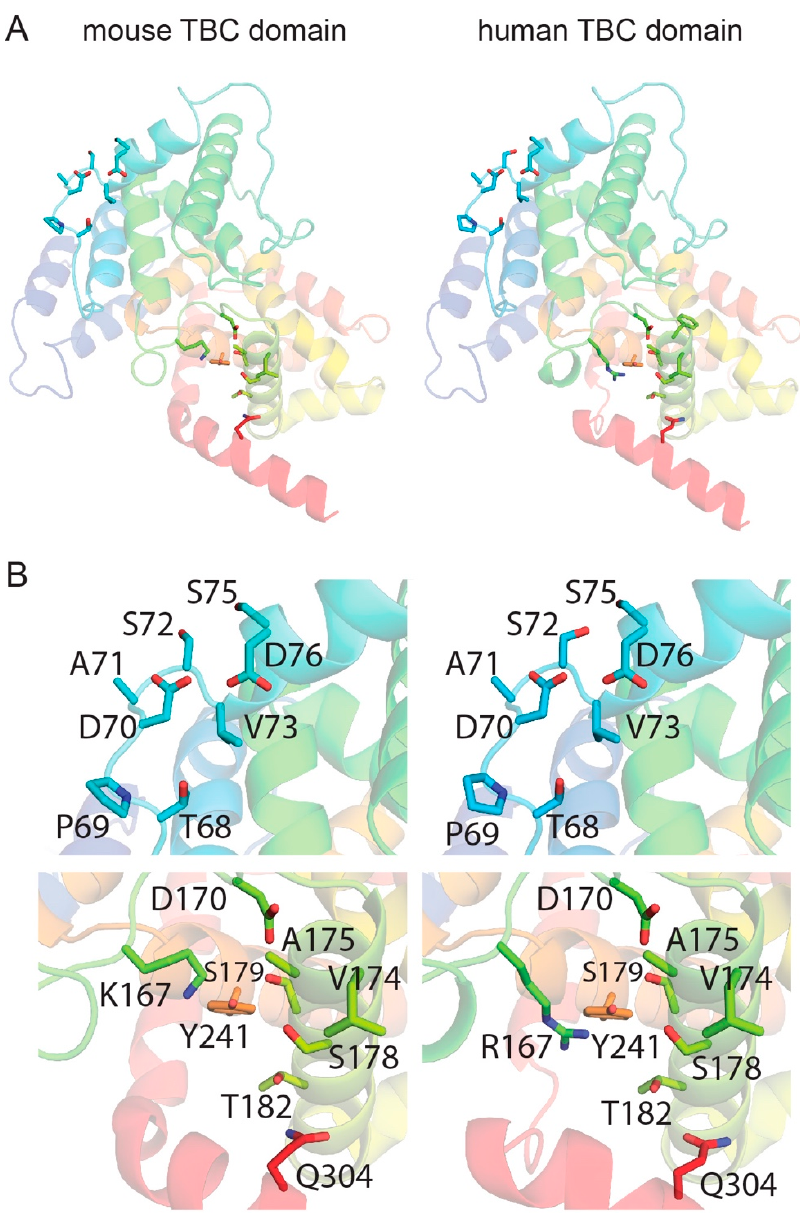
Figure 5. Computational modeling of human TBC1D24 and mouse TBC1D24. ( A ) Models of the TBC domains of mouse (left) and human (right) of TBC1D24 shown as a cartoon. Residues Asp70 and Ser178 as well as those within 6 Å are shown as sticks. ( B ) Enlarged view of the Asp70 (top) and Ser178 (bottom) sites in mouse (left) and human (right) models. Residues within 6 Å of Asp70 or Ser178 are also shown as sticks and indicated with labels. A, Alanine; D, Aspartic acid; K, Lysine; P, Proline; Q, Glutamine; R, Arginine; S, Serine; T, Threonine; V, Valine; Y, Tyrosine.